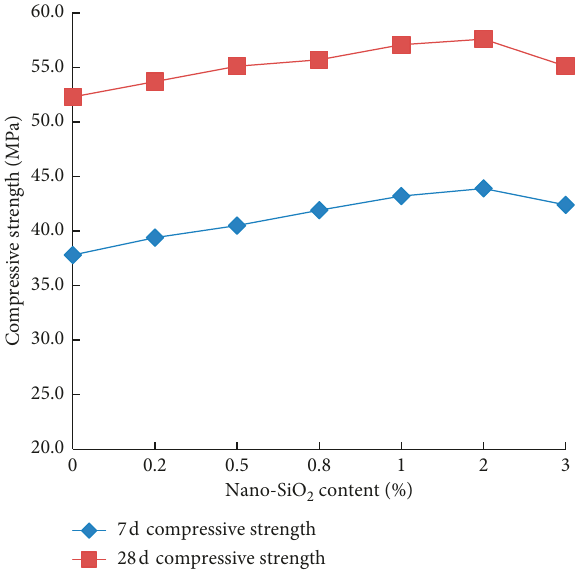
Figure 2: Flexural strength test results.